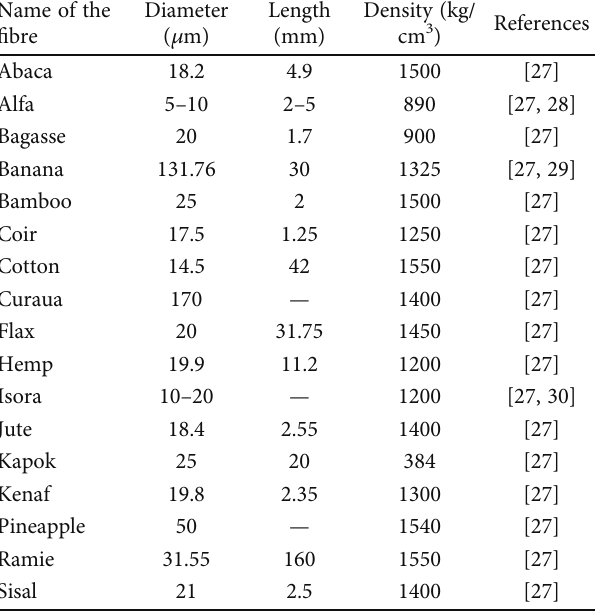
Table 1: Physical properties of natural fi bres. Name of the fi